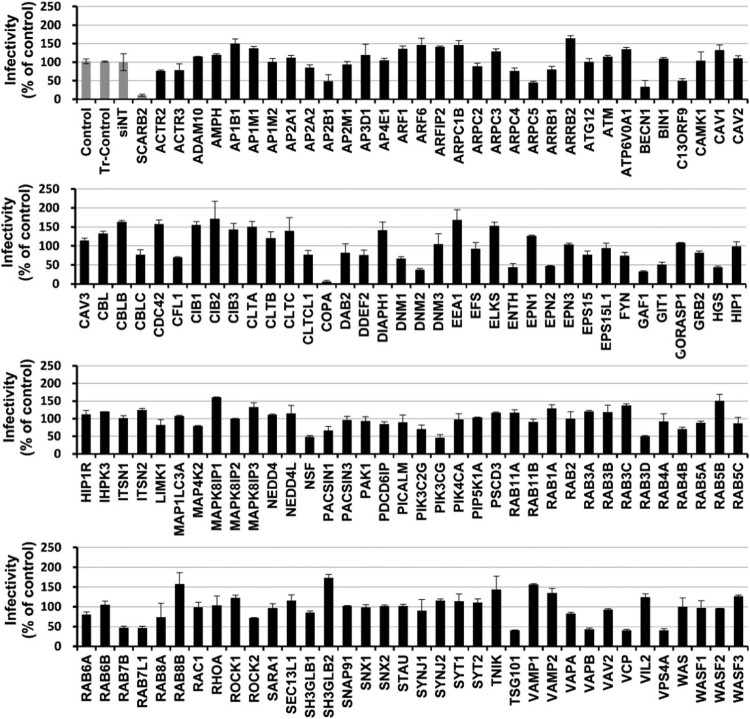
Identification of membrane-trafficking factors involved in EV71 infection Caco-2 cells were transfected with Human Membrane Trafficking siRNA library. Sixty hours post-transfection, the cells were infected with EV71 (MOI = 10) for 48 h before immunofluorescence assays were performed to detect EV71. The number of infected cells and the total cells were assessed by automated microscopy and image analysis. EV71-infected cells after siRNA knockdown were compared to controls and are presented as the percentage of viral antigen-positive cells. The transfection controls (Tr-control) were established as the baseline for infection and transfection efficiency. Genes showing a >50% decrease in EV71 infectivity compared to the control group were considered for further analysis. Values are normalized to control group. SiNT: non-targeting siRNA.